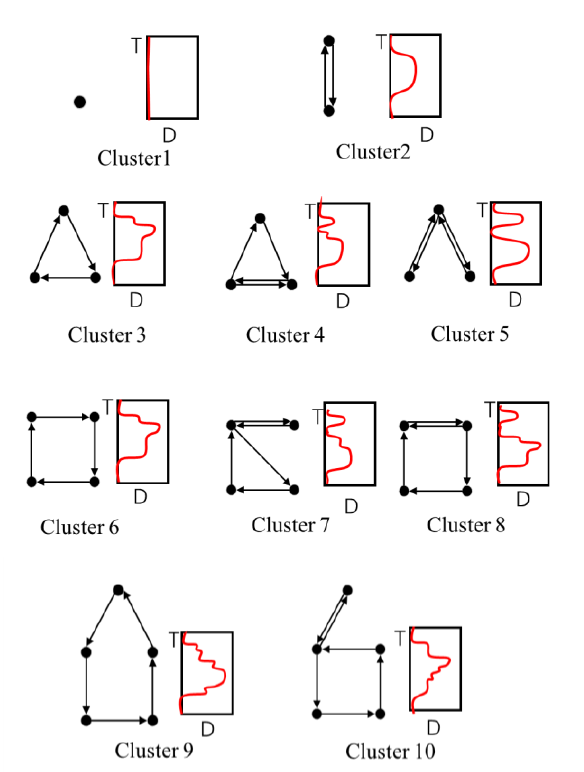
Figure 5. Trajectory clusters. A node denotes one visiting place. An edge denotes a move between places. T is the time dimension. D is the distance from the centre of a user’ trajectory